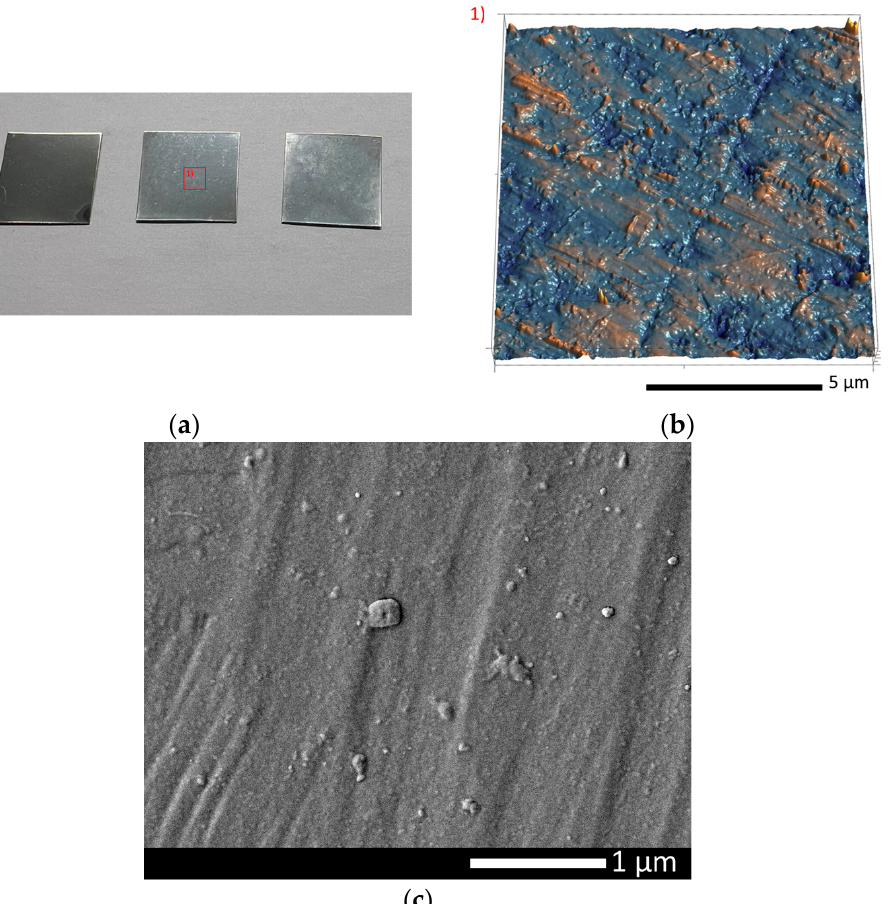
Figure 1. Data on the morphological features of the obtained samples of NbTiVZr alloys: ( a ) general view of the obtained samples; ( b ) 3D reconstruction of the sample surface after polishing; ( c ) SEM image of the sample surface.